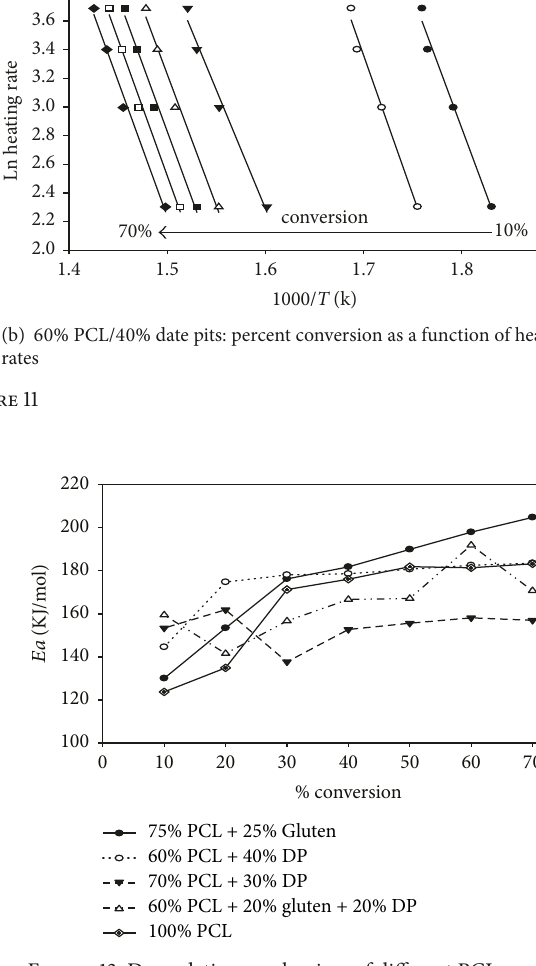
PLA intensified at higher DP and less in the presence of VG (Figure